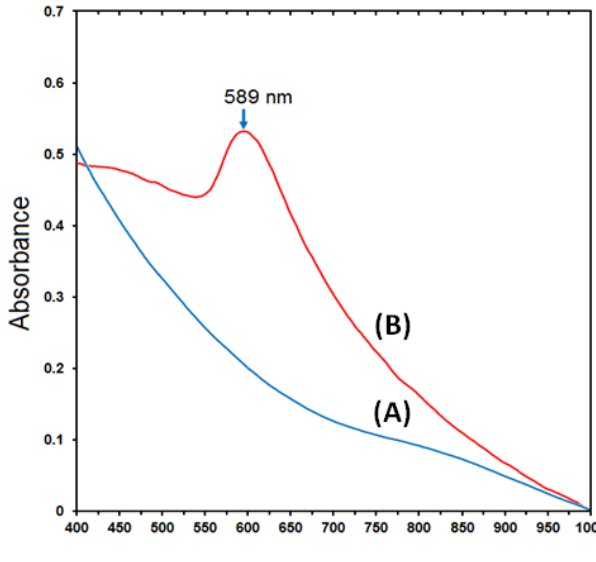
Figure 2. UV-Vis absorption spectra of Cu-NPs in Cts with NaOH ( A ) and 0.1% Cts ( B